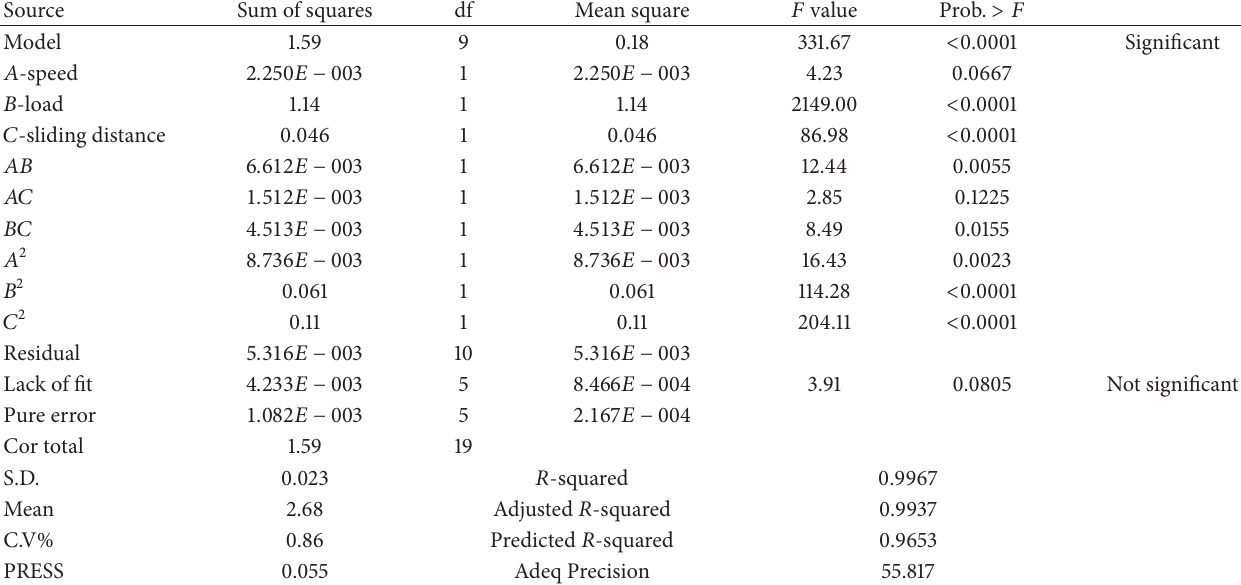
Table 4: The results of ANOVA table for quadratic model for specific wear rate × 10 − 1 (mm 3